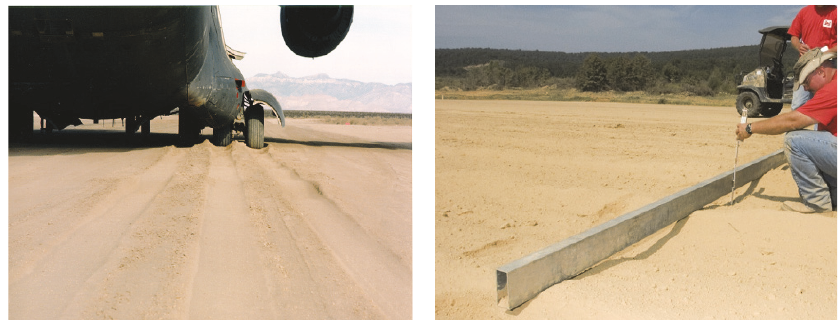
Figure 2: Formation of rutting on the soil pavement during aircraft take-off and